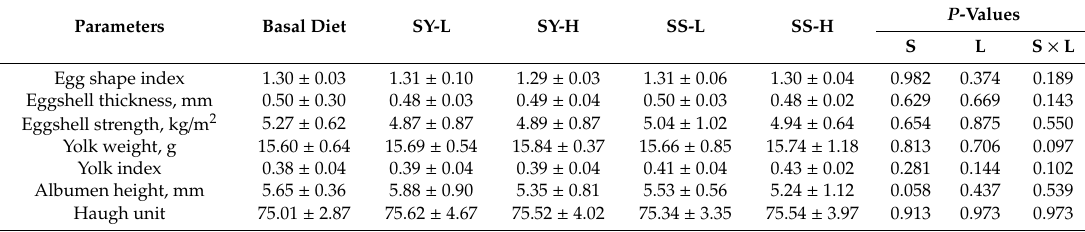
Table 3. E ff ects of dietary supplementation of di ff erent selenium sources and levels on egg quality of laying